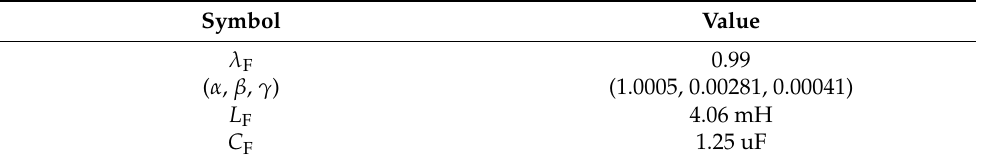
Table 4. Preset and filter parameters.